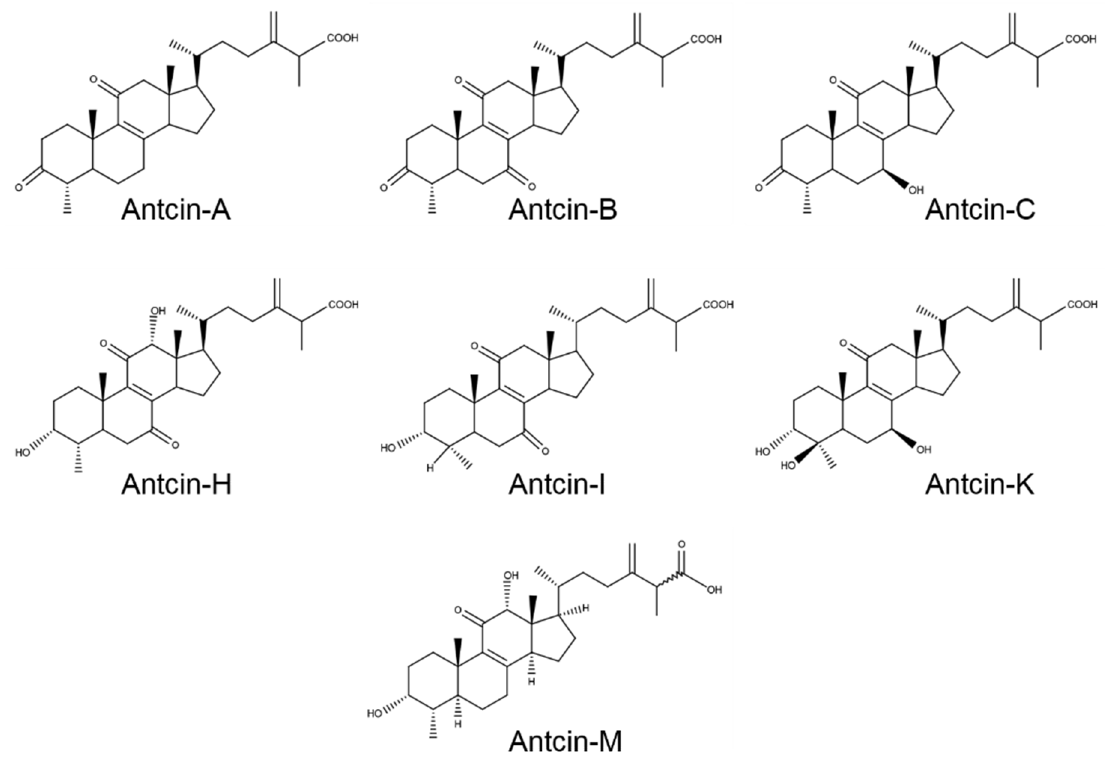
Figure 1. Chemical structure of antcins.